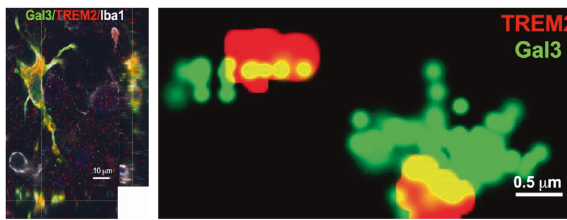
Fig. 2 Illustration from Boza-Serrano et al. 2019 [13]: Gal-3 interacts with TREM2. Left panel: Gal-3 and TREM2 in plaque- associated microglia in the brain of 5xFAD mice reveal colocalisation of Gal-3 and TREM2. Right panel: Gal-3 and TREM2 interaction in 5xFAD mouse brain using Stochastic Optical Reconstruction Micro- scopy (STORM). All images were taken in 5xFAD mice at 18